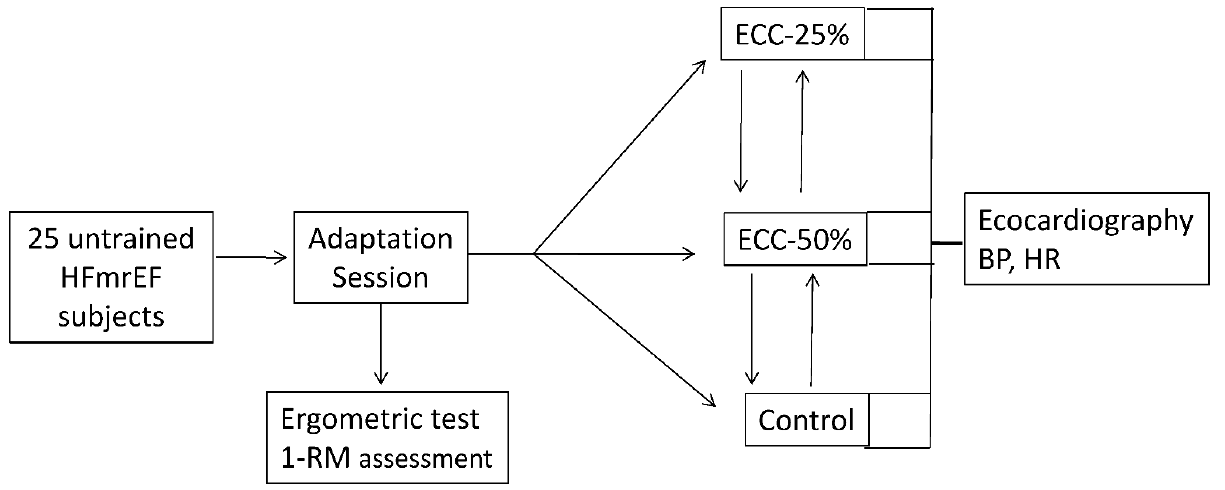
Figure 1. Study flowchart.